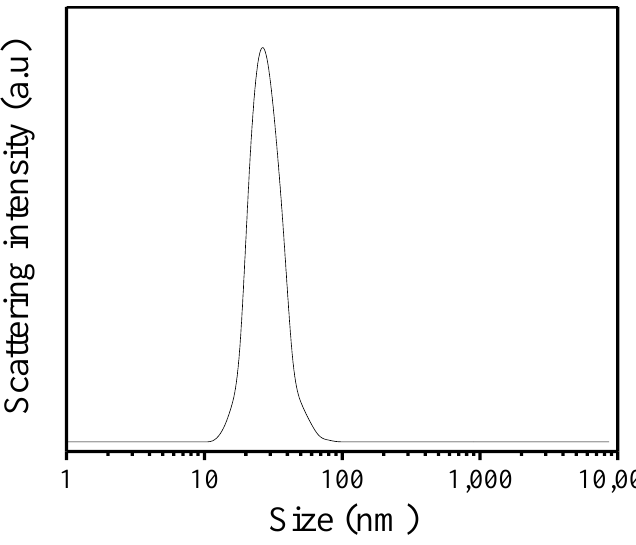
Figure 3. DLS curve of as-synthesized Fe-LTL-N.